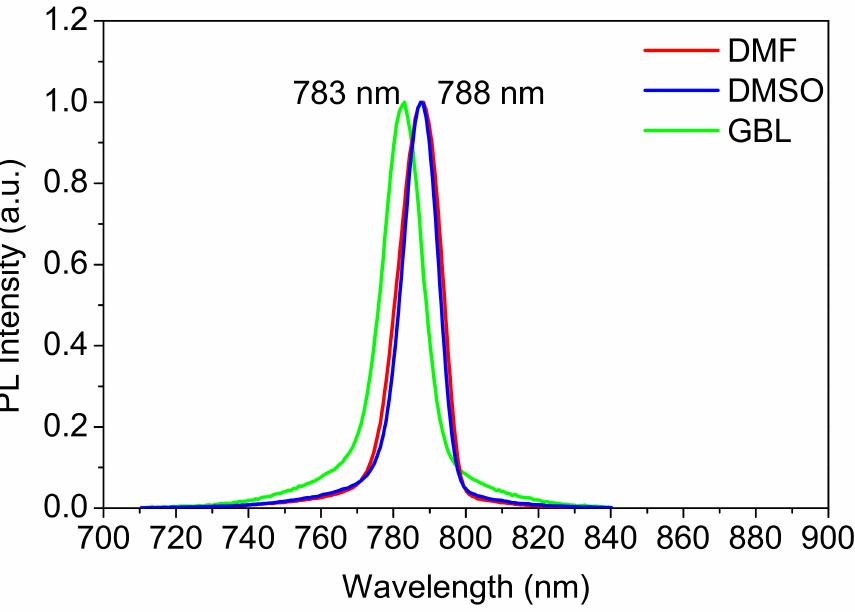
Figure 7. PL spectra of the MAPbI 3 perovskite thin films prepared using different solvents under high energy